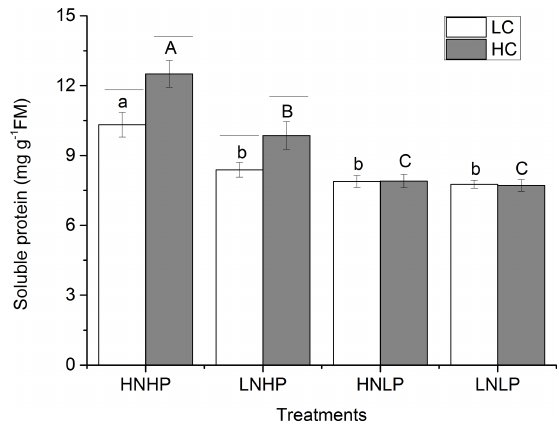
Figure 7. Content of soluble protein in adult U. linza grown under various conditions. LC, 400µatm; HC, 1000µatm; LN, 6.1µmolL − 1 ; LP, 0.2µmolL − 1 ; HN, 106.1µmolL − 1 ; HP, 10.2µmolL − 1 . The error bars indicate the standard deviations ( n = 3). Different letters (lower case for LC and capital for HC) above the error bars represent significant differences ( P < 0.05) among nu- trient treatments while horizontal bars represent significant differ- ences ( P < 0.05) between LC and HC within a nutrient